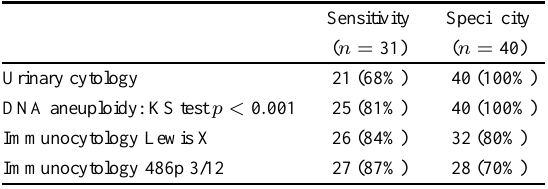
Detection of 71 patients with bladder cancer by urinary cytology, DNA-image-cytometry, Lewis X and 486p 3/12 antigen